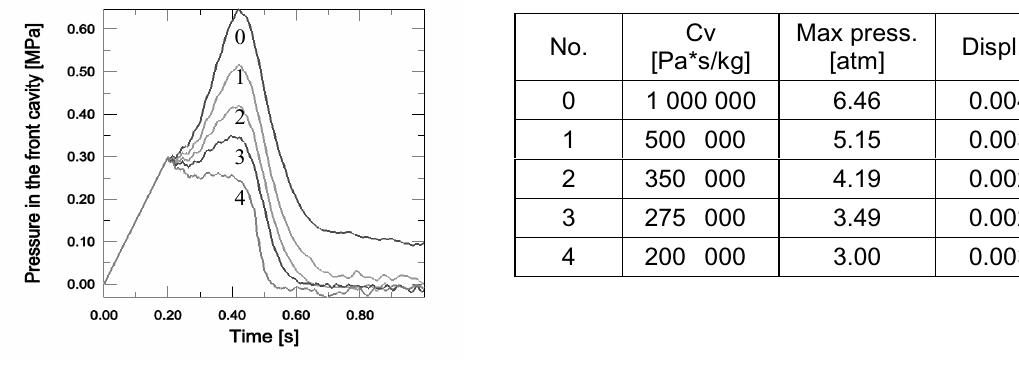
Fig. 13. Semi-active mitigation of tower vibrations: a) change of pressure and b) corresponding response of the